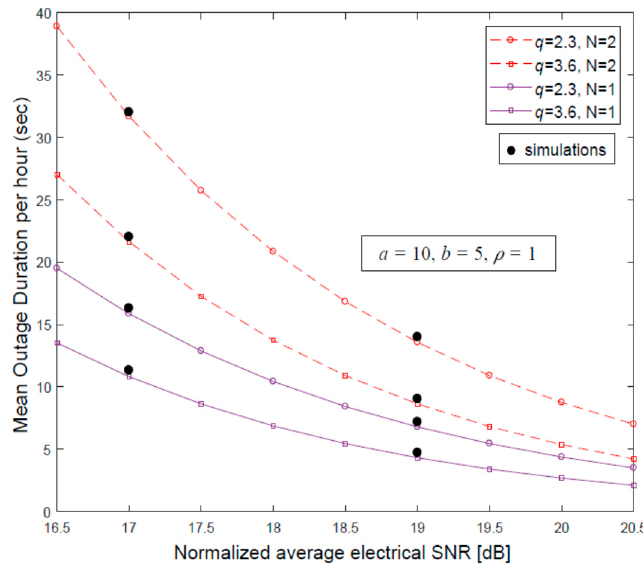
Figure 5. Mean outage duration (MOD) per hour versus normalized average electrical SNR of single-hop or dual-hop FSO configurations for weak turbulence strengths, as well as weak and moderate amounts of non-zero boresight pointing errors.